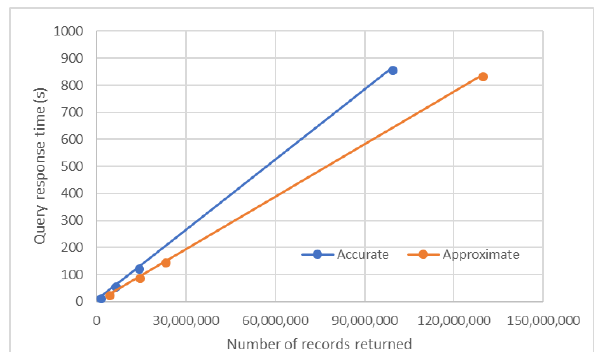
Figure 7. Comparison between the accurate spatial selections on the S3SDISFLAT table and the approximate selections on the S3OBJ_NEST table.